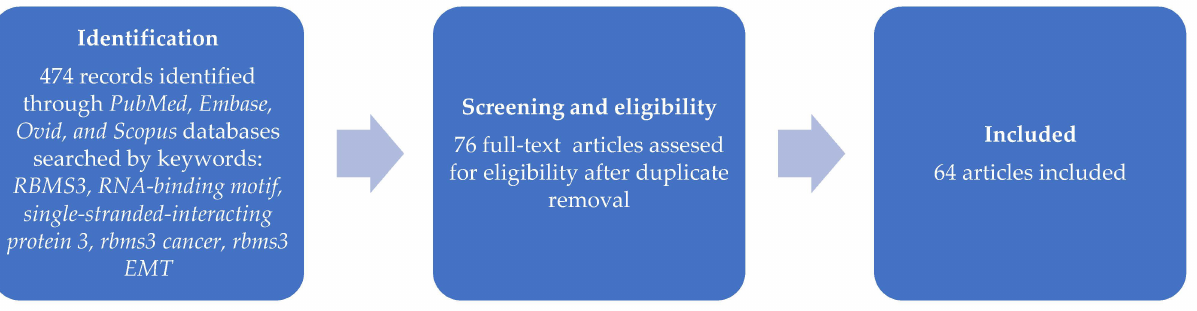
Figure 1. Workflow literature